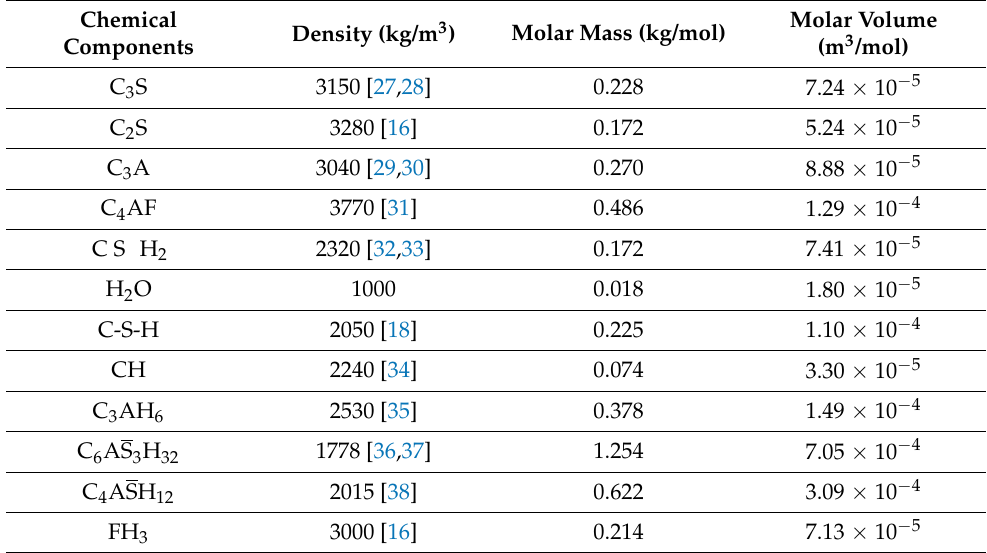
Table 1. Physical properties of various chemical components during cement